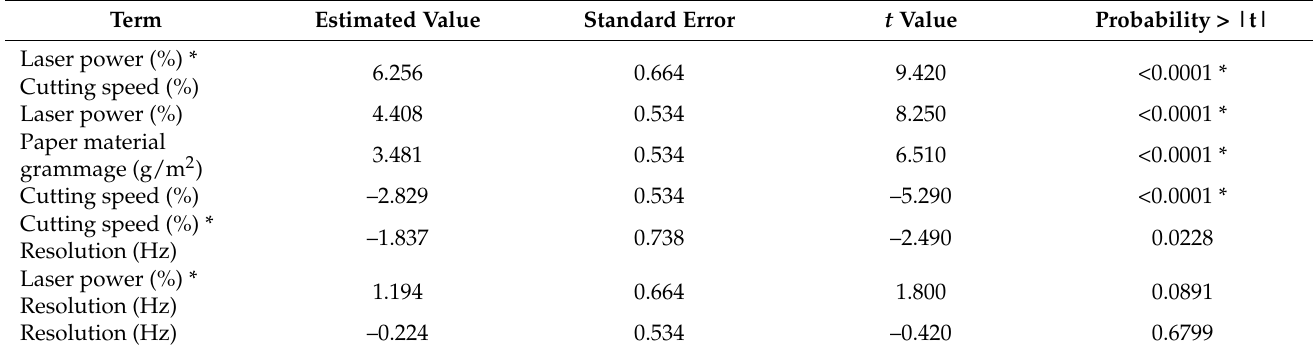
Table 7. Estimated coefficients of the significant main parameters and two-way